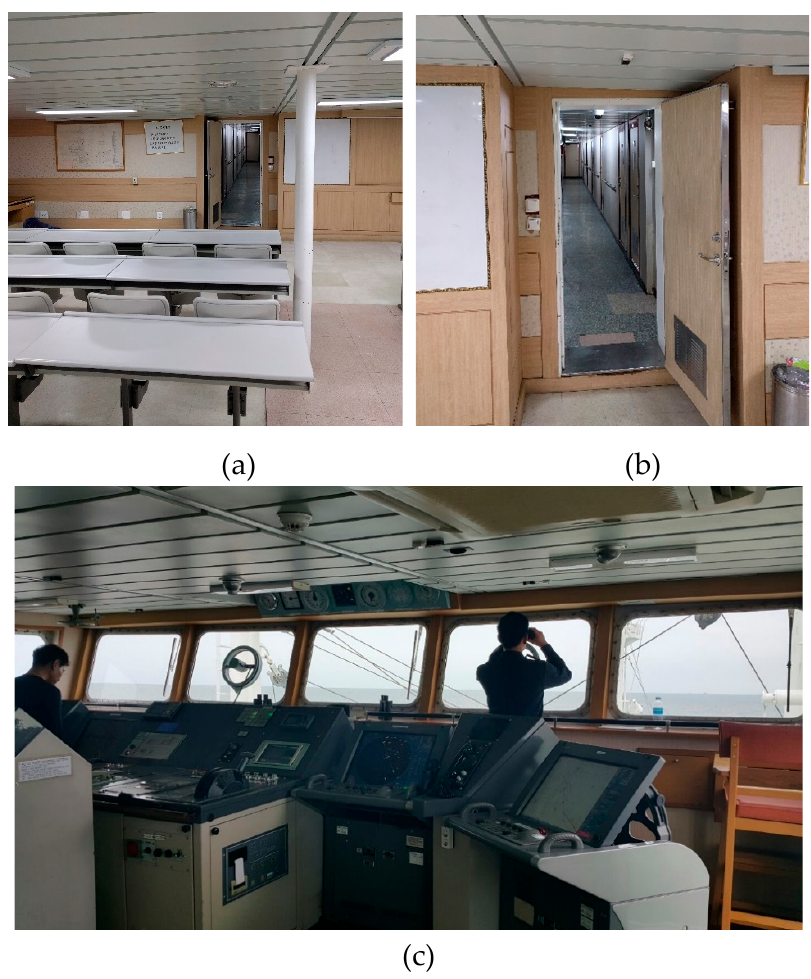
Figure 2. Ship accommodation including lecture room ( a ), hallway ( b ), and navigation bridge ( c ).